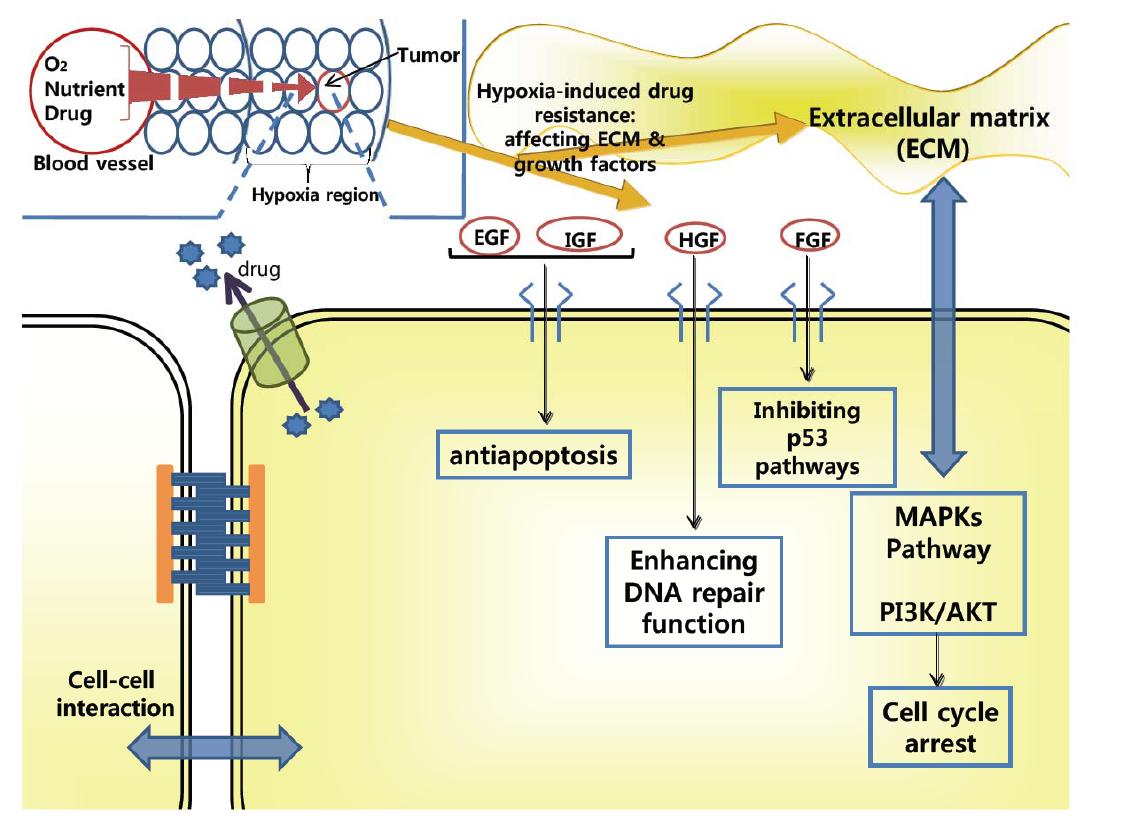
Figure 2. Drug-resistance mechanisms (such as soluble growth factors, ECM-based drug resistance, cell-cell interaction, and hypoxia-induced drug resistance) in the tumor microenvironment. See text for